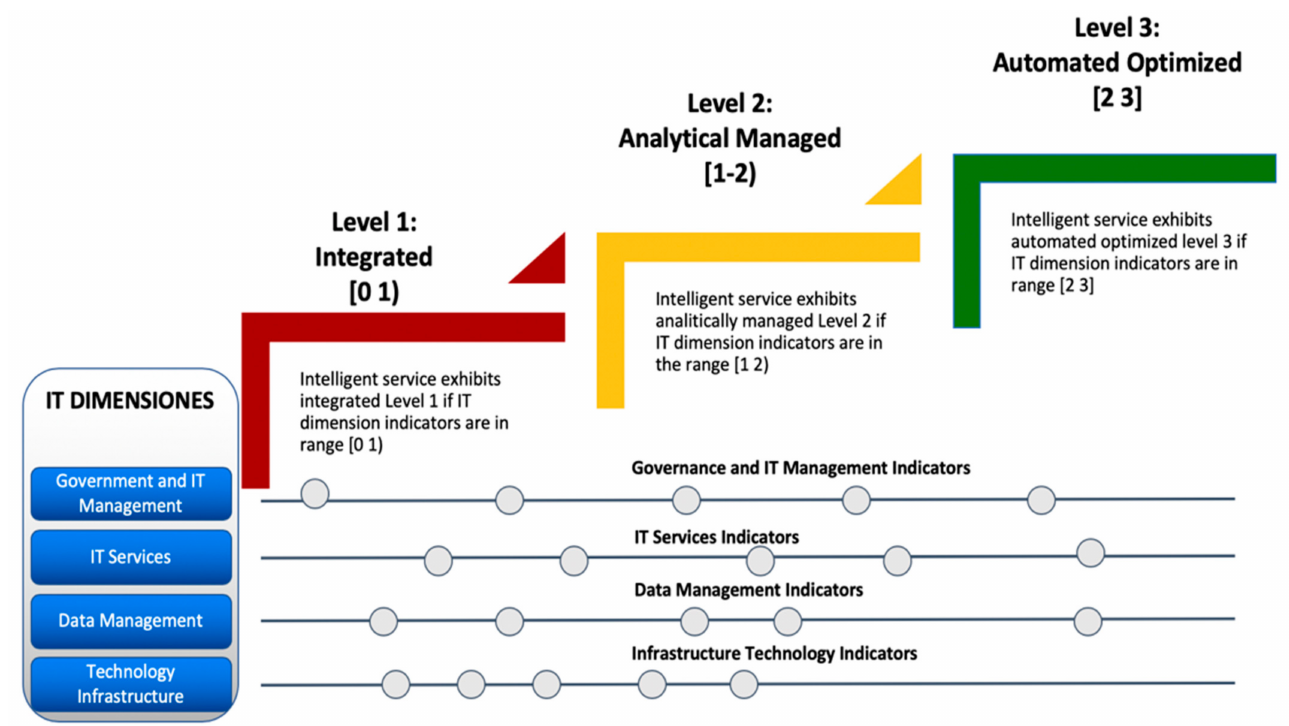
Figure 2. Quantitative model levels of maturity for dimensions